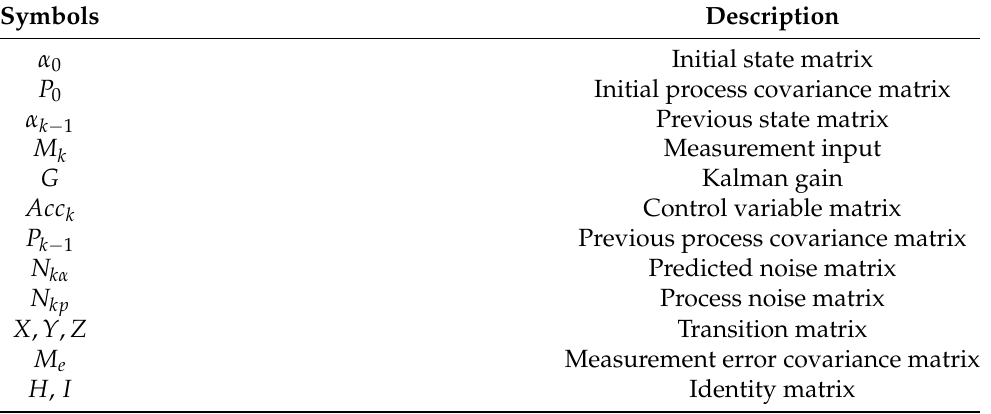
Table 2. Kalman filter